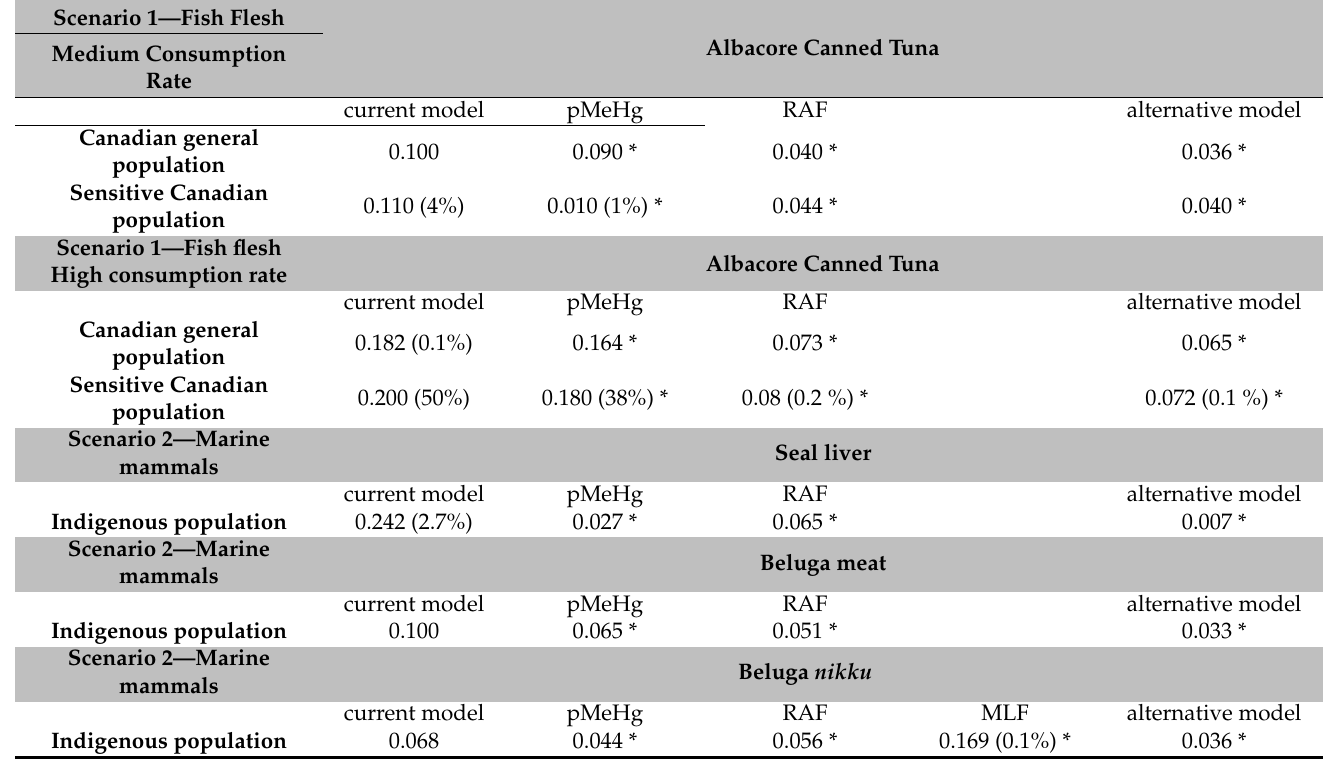
Table 2. Independent impact of adding a single variable in the equation of the exposure of MeHg. Results are expressed as median of MeHg daily exposure dose ( µ g × kg − 1 bw) and the percentage of the distribution of exposure that exceeds the TDI value is in parentheses (no number signifies 0%). Alternative model shows the resulting MeHg daily exposure when all the proposed variables are integrated simultaneously into the exposure equation. See Table S1 for the details on variables used for each scenario. * are used to indicate a significative difference ( p < 0.05) between the exposure distribution compared to the current model. pMeHg: proportion of THg that is methylated; RAF: relative absorption factor; MLF: mass loss